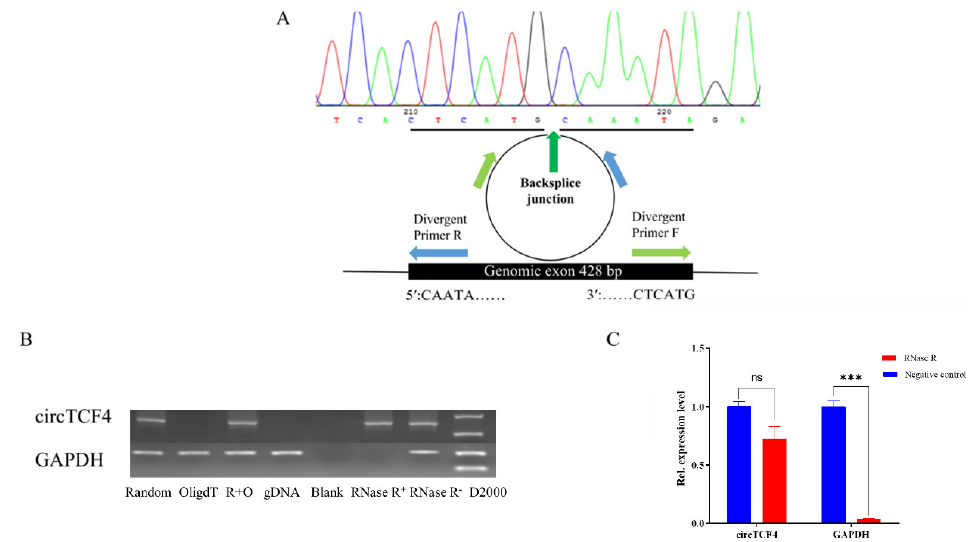
Figure 1. Characterization of Goat circTCF4. ( A ), Sequencing results of circTCF4 splicing junction. ( B ), PCR amplification results of circTCF4 in cDNA obtained by Random primer reverse transcription, OligdT primer reverse transcription, Random + OligdT primer reverse transcription, gDNA (genome DNA), and blank control, and RNase R treated group, respectively. ( C ), circTCF4 and GAPDH abundance in RNase R digested samples. Data are means ± standard error of the mean of at least three biological replicates, *** p < 0.001.